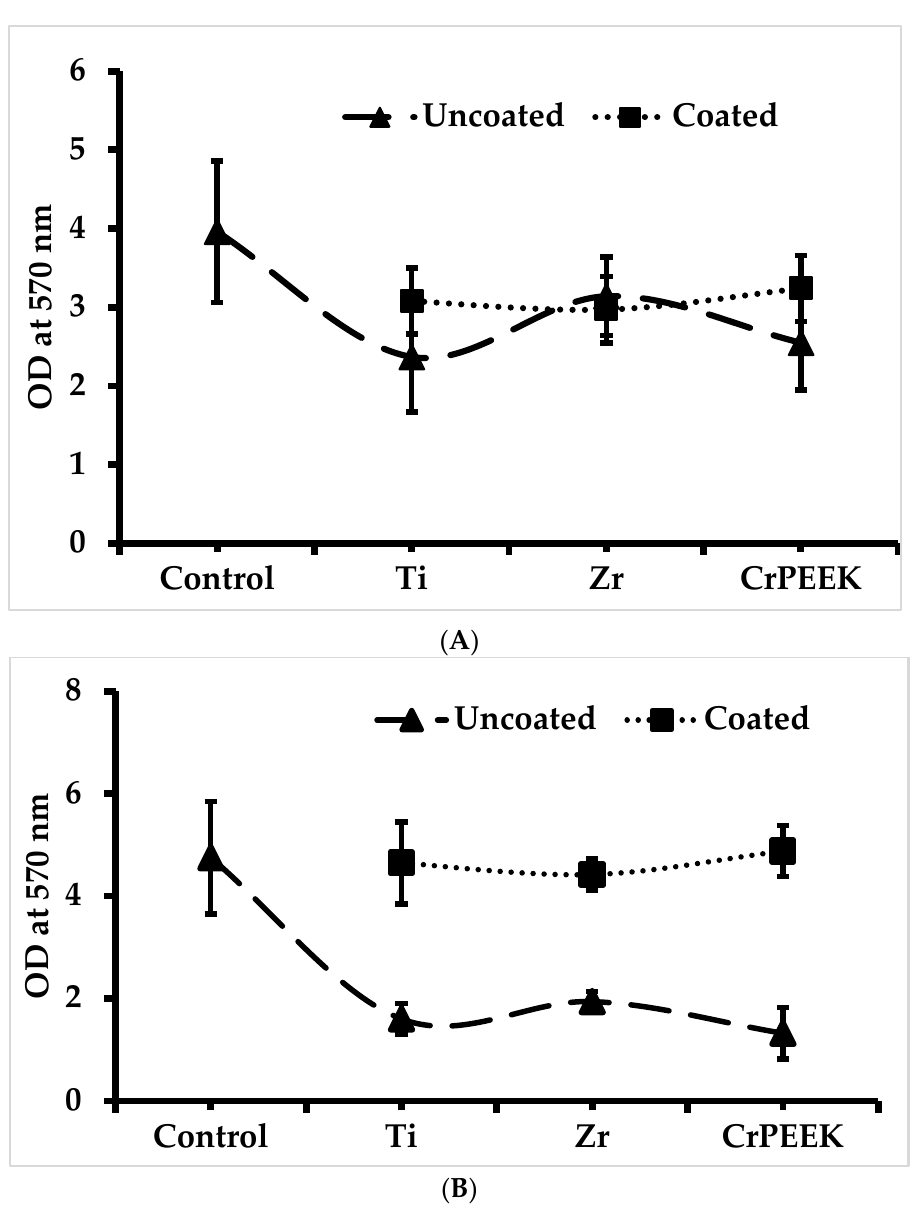
Figure 6. ( A ) Attachment assay of S. aureus on tested samples, with increased affinity observed after coating the samples with NaOH. Control—without samples. ( B ) Attachment assay of E. coli on tested samples. No significant increase in affinity level could be observed after coating the samples. Values are mean + standard deviation.